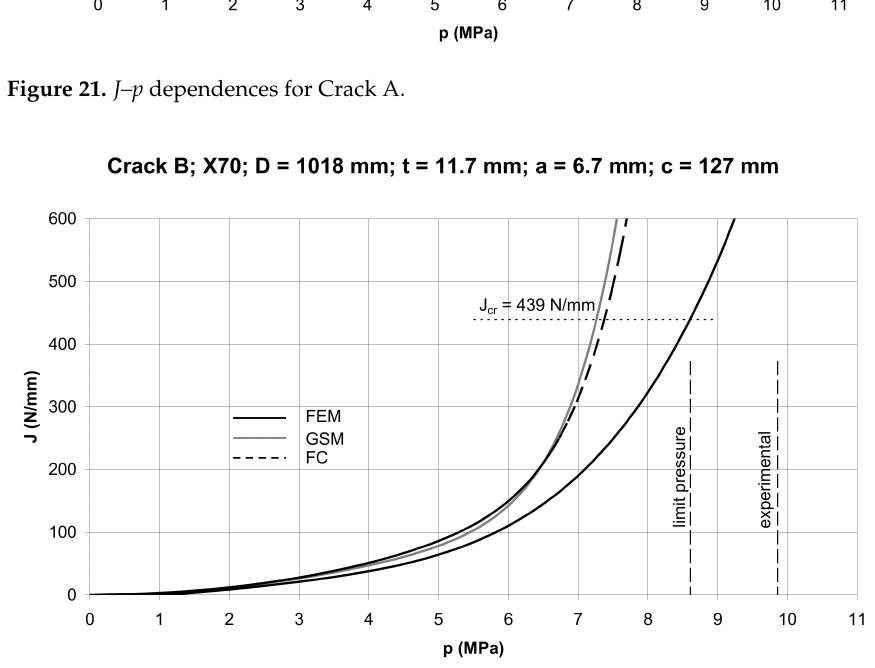
Figure 22. J–p dependences for Crack